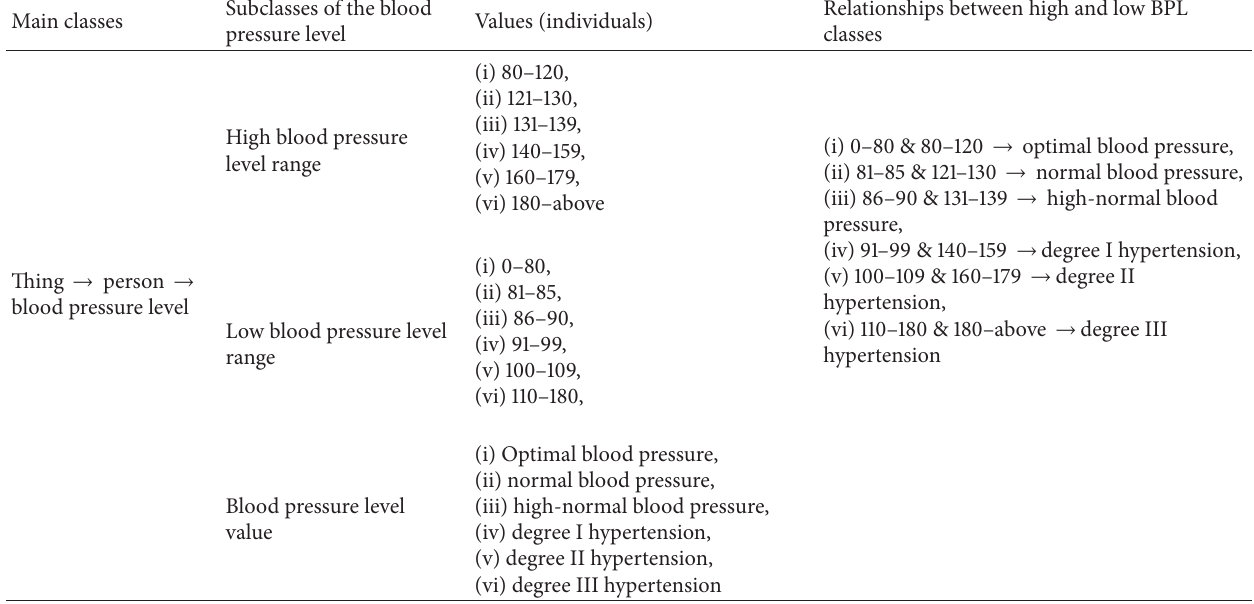
Table 4: Blood pressure level class includes three subclasses: high blood pressure level range, low blood pressure level range, and blood pressure level value, with their values for individuals.